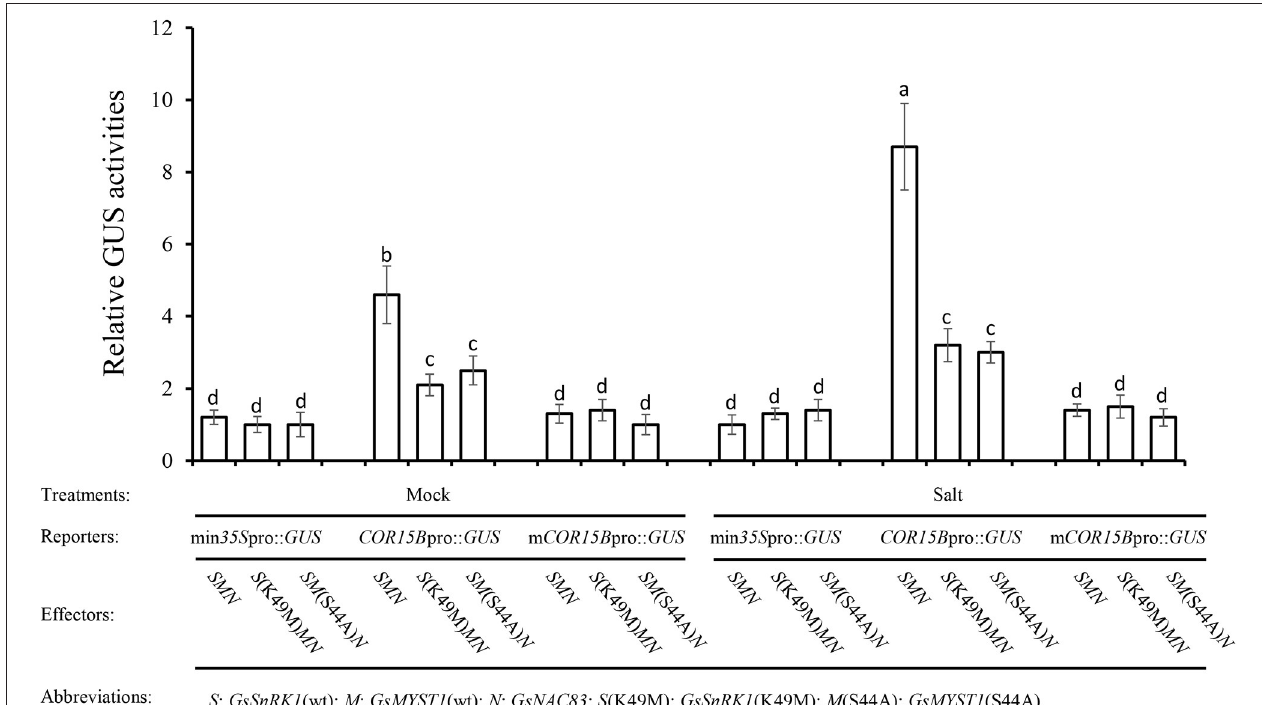
FIGURE 7 | GsSnRK1-GsMYST1-GsNAC83G module mediates salt stress signal. The reporter and the effector constructs were cotransformed into Arabidopsis protoplasts. After 16-h incubation, the protoplasts were treated with 10mM NaCl for 2h, and total proteins were extracted for quantitative measurements of GUS activities. Bars indicate SE, the t-test, and the columns were shown from three biological triplicates ( t -test, p < 0.05, expressed in different small letter alphabets).